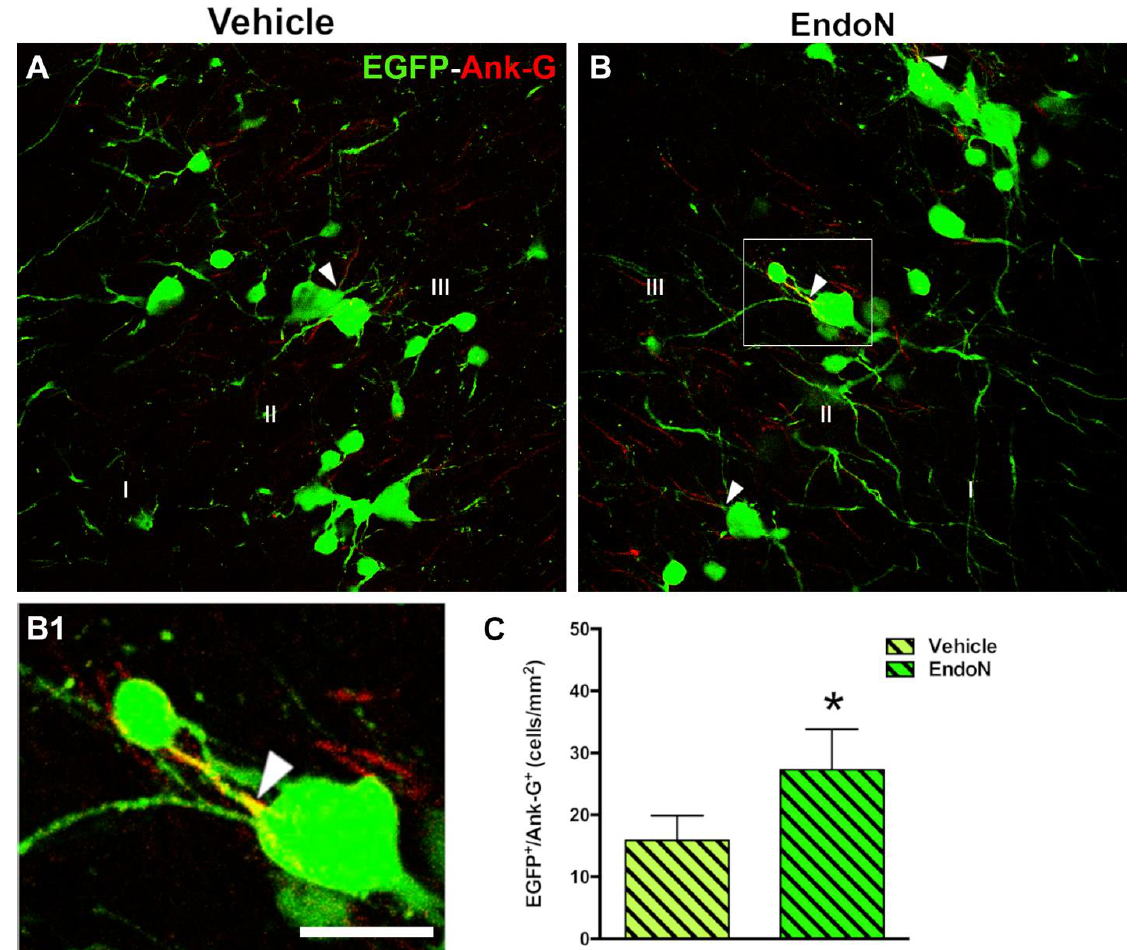
Figure 5. Effects of Endo-N injection on the density of EGFP + complex cells displaying an AIS. ( A , B ) Panoramic views of the PCX layer II with EGFP + cells (green) showing axon initial segments (AIS) (red) identified by the expression of the protein Ank-G. Note the presence of a larger number of EGFP + complex cells displaying an AIS in the Endo-N hemisphere. ( B1 ) Higher magnification of the squared area in B. An arrowhead indicates the AIS. ( C ) Graph showing a higher density of EGFP + complex cells expressing Ank-G in the Endo-N hemisphere. Asterisks indicate statistically significant differences between hemispheres (Vehicle vs. Endo-N) after paired Student’s t -test. (* p ≤ 0.05) Scale bar represents 30 µ m for A and B, and 55 µ m for